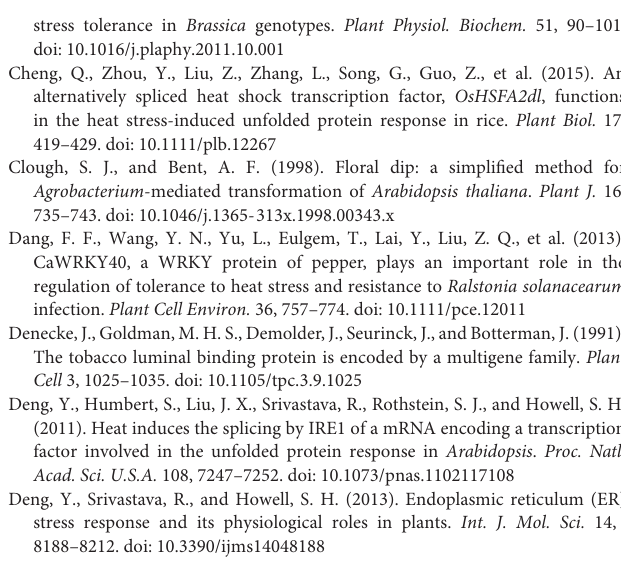
FIGURE S1 | Confirmation of CaBiP1 -silenced pepper seedlings and CaBiP1 -overexpressing Arabidopsis lines. (A) Phenotypes of CaBiP1 -silenced pepper seedlings. CaPDS , phytoene desaturase gene for chlorophyll synthesis; TRV2:00, control plants harboring the empty TRV2 vector. (B) Measurement of the silencing efficiency for CaBiP1 expression in silenced pepper seedlings at the 30th day after inoculation. (C) Screening of CaBiP1 -overexpressing Arabidopsis lines in MS medium containing kanamycin. (D) Measurement of CaBiP1 expression levels in CaBiP1 -overexpressing Arabidopsis lines by semi-quantitative PCR. The AtActin2 gene was used as the internal control. Error bars represent standard deviation from three biological replicates. FIGURE S2 | Enhanced tolerance to ER stress induced by DTT in CaBiP1 -overexpressing Arabidsopsis lines. (A) Germination rate on MS medium with 3 mM DTT. (B) Fresh weight of 5-day-old CaBiP1 -OE Arabidsopsis seedlings grown on MS medium with 2 mM DTT for 15 days. Data represent the mean ± standard deviation from three biological replicates. Statistical significance is indicated as by a single asterisk ( p < 0.05) and double asterisk ( p < 0.01) based on the results of the Student’s t -test. FIGURE S3 | Seed germination rate in WT and CaBiP1 -OE (OE7 and OE8) Arabidsopsis lines grown on MS medium with 100 mM NaCl. Data represent the mean ± standard deviation from three biological replicates. Statistical significance is indicated by a single asterisk ( p < 0.05) based on the results of the Student’s t